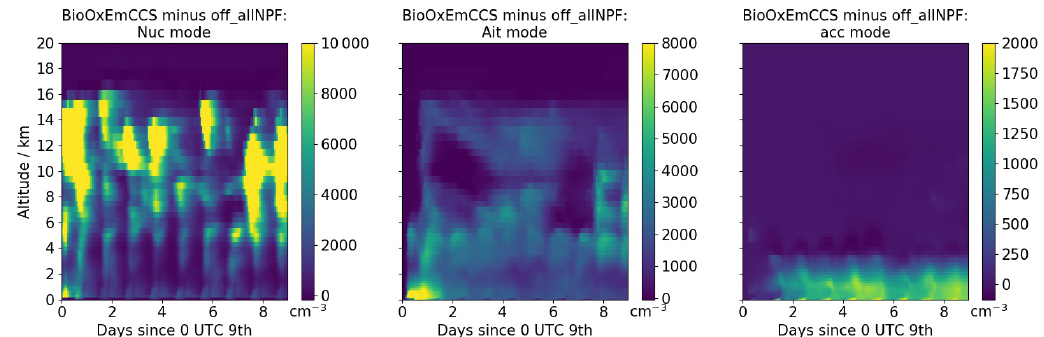
Figure A4. Time series of the global domain-averaged aerosol number concentrations at the same location of the regional domain. The number concentrations are the differences between the BioOxEmCCS and off_allNPF simulations.